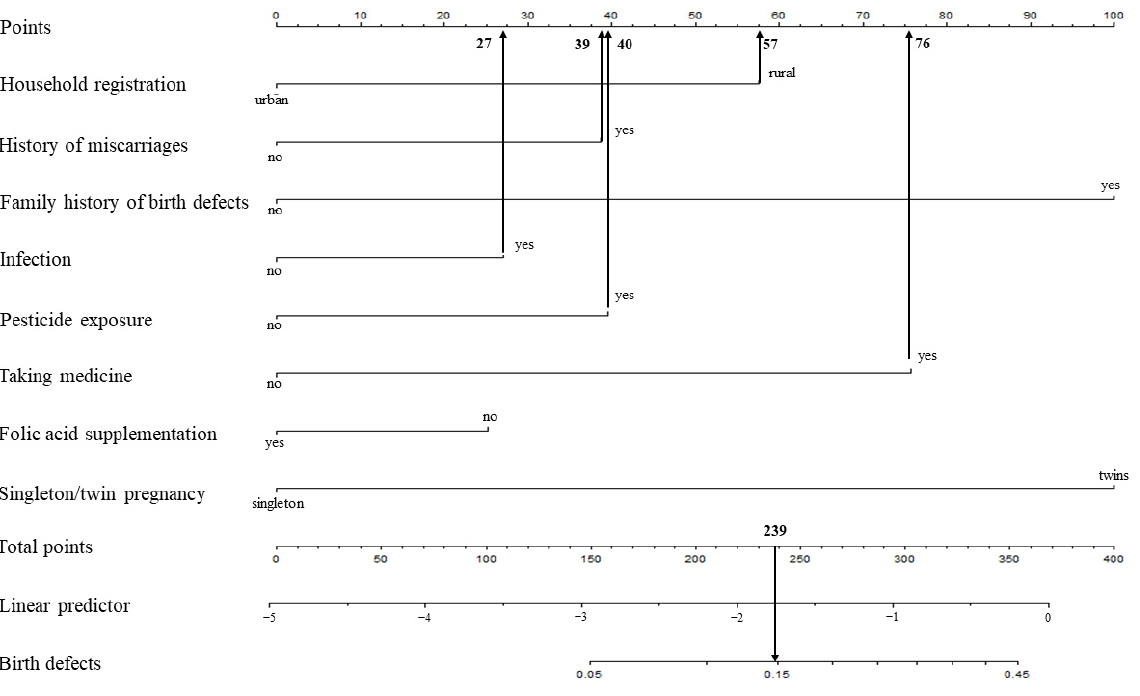
Figure 2. Example prediction nomogram for risk of birth defects.